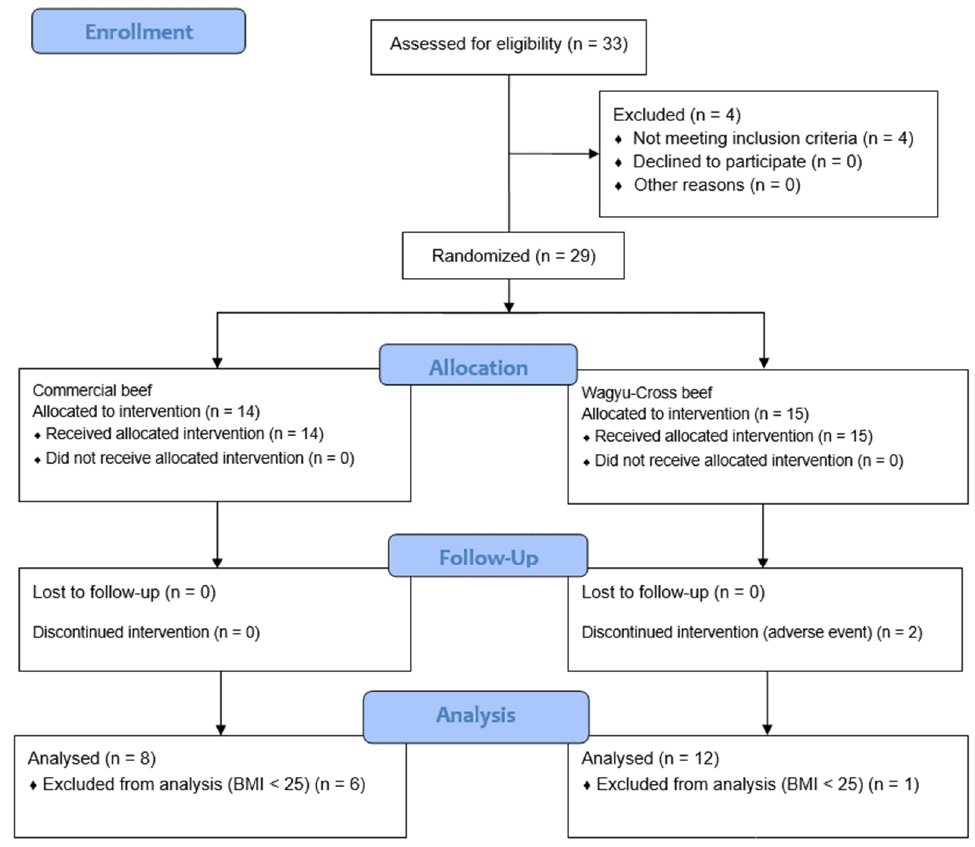
Figure 1. CONSORT flow diagram of the numbers of volunteers screened, included, eliminated, and analyzed in the present study.